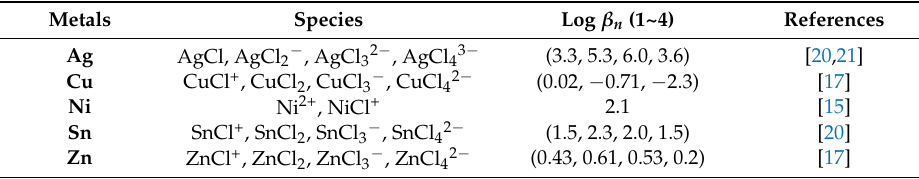
Table 3. The stability constants for the formation of chloro-complexes in HCl solution.